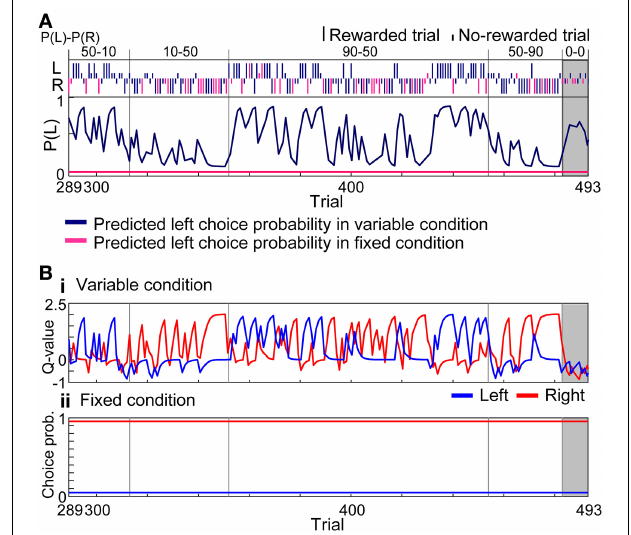
FIGURE 5 | Learning interference model. (A) Prediction of choice probability. The learning interference model predicted choice behaviors of rat in Figure 3 between the 289 and 493 trials. Trials consisted of all four reward-probability settings in the variable-reward condition and the extinction phase. FQ-learning and fixed-choice models were employed as learning rules of variable- and fixed-reward conditions, respectively. Free parameters of the learning interference model were set to achieve maximum likelihood in this session. Dark blue and pink lines show predicted left choice probabilities of the model in variable- and fixed-reward conditions, respectively. Other lines and symbols are as in Figure 3 . The learning interference model accurately predicted the choice behaviors of rat. (B) Model variables. (i) Action values of the variable-reward condition were predicted by FQ-learning. (ii) Choice probabilities in the fixed-reward condition were predicted by the fixed-choice